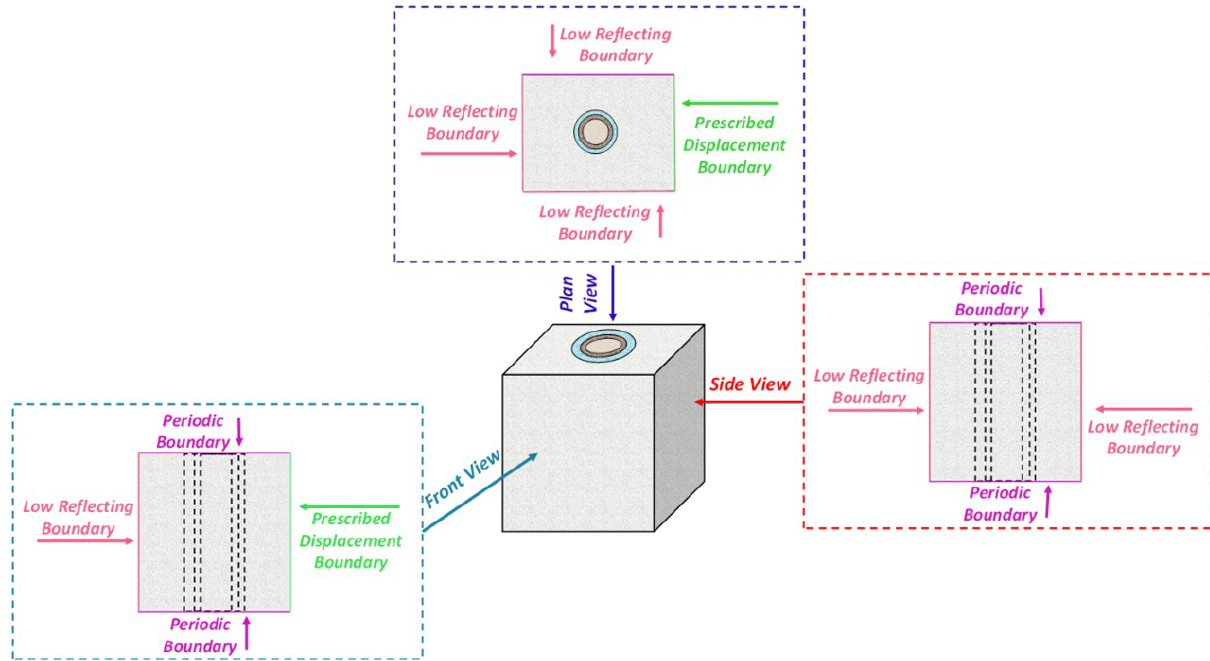
Figure 4. Illustration showing how the boundary conditions are assigned for the 3D model.